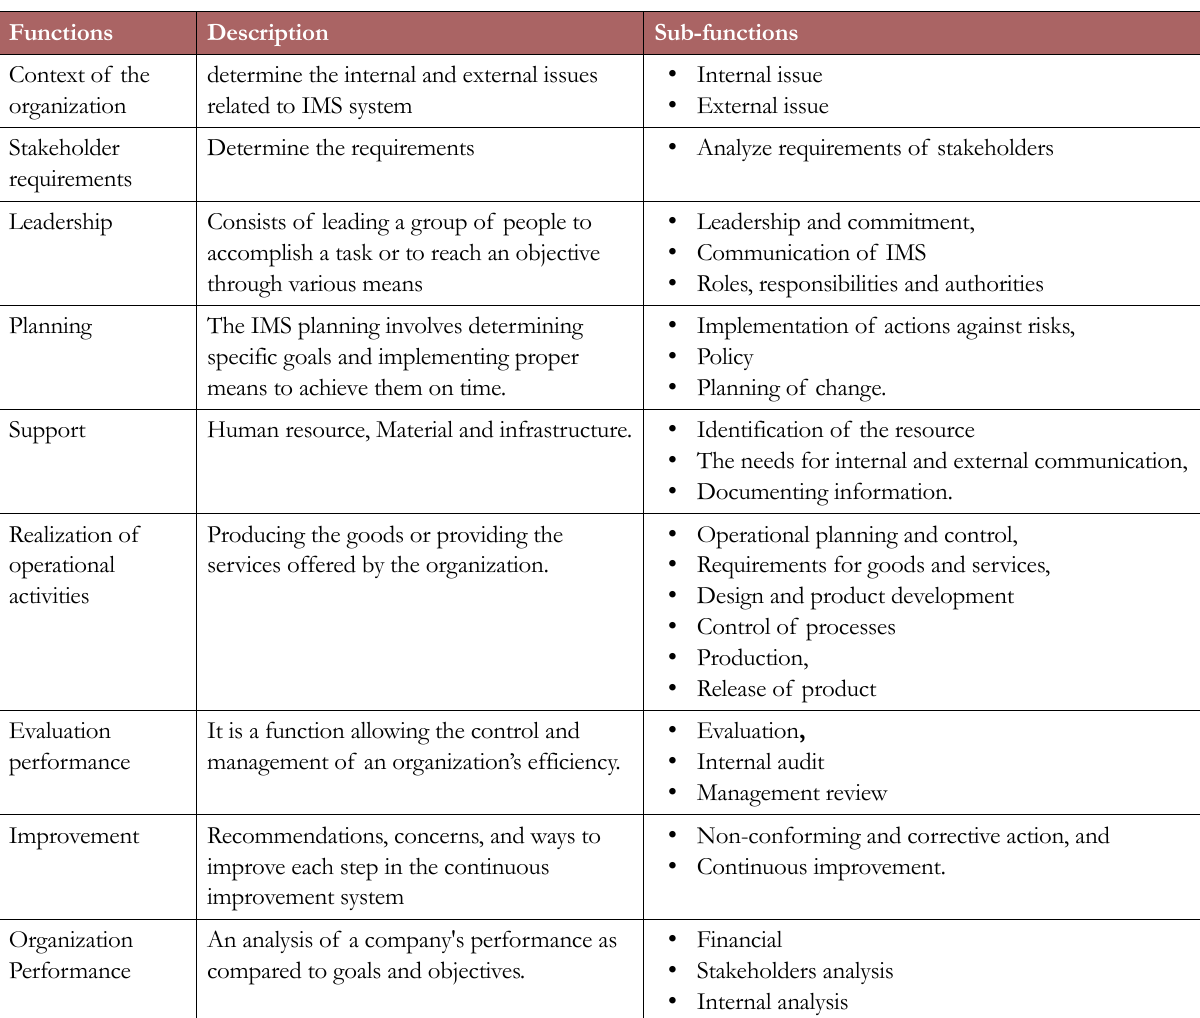
Table 1. Description of the IMS functions by APTE